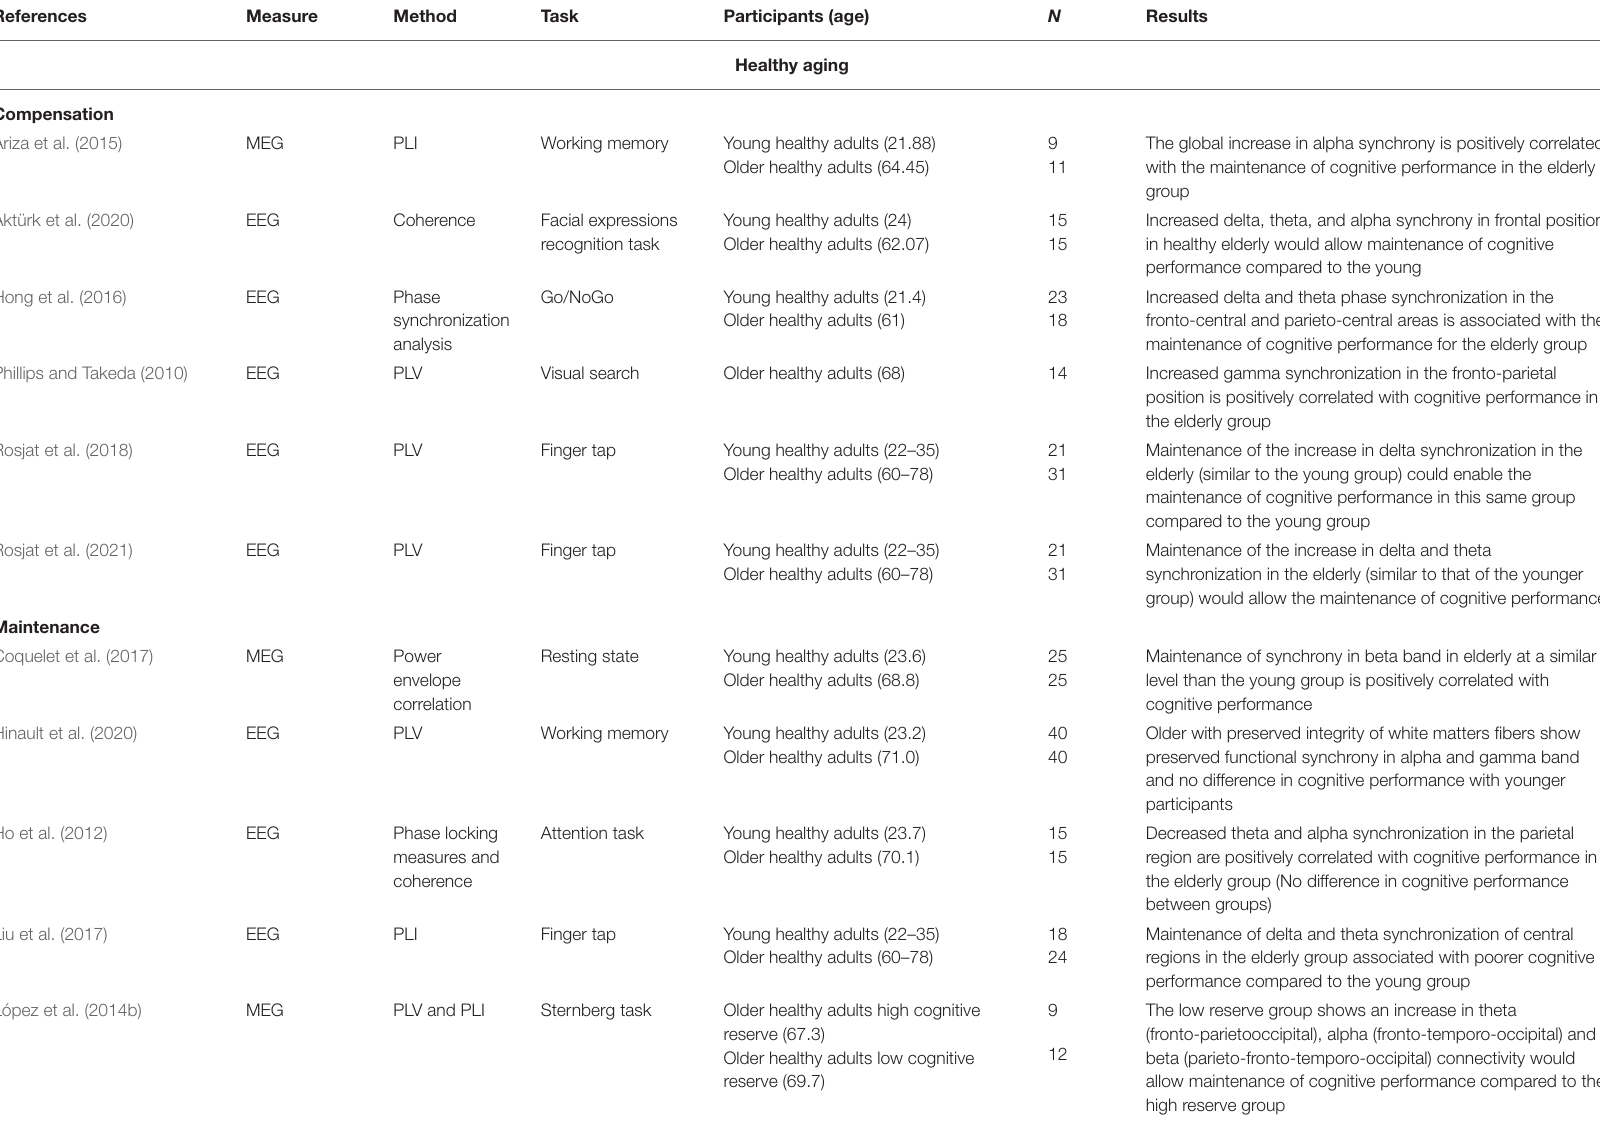
TABLE 1 | Summary of the